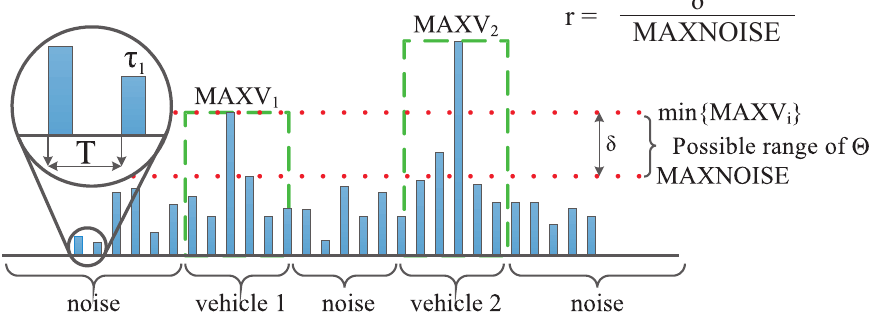
Figure 6. The derivation of the robustness parameter, r . The sensor is switched on with period T for time τ 1